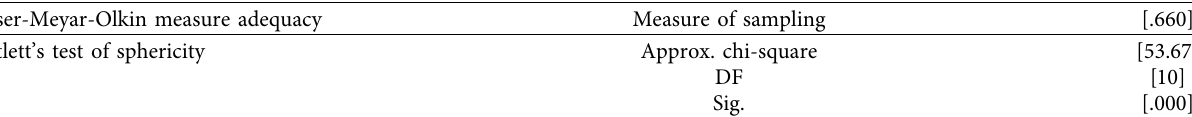
Figure 2: Best Fitted Graph of Multiple Linear regression. Table 3: KMO and Bartlett’s test.